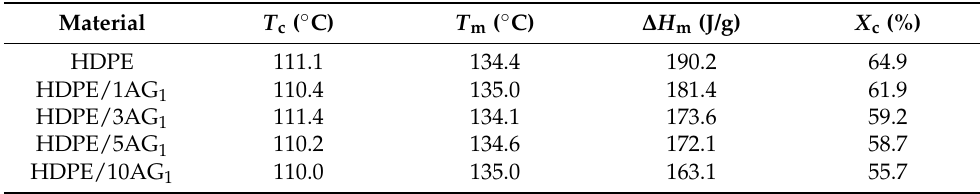
Table 1. DSC results on HDPE and HDPE/AG 1 composites.